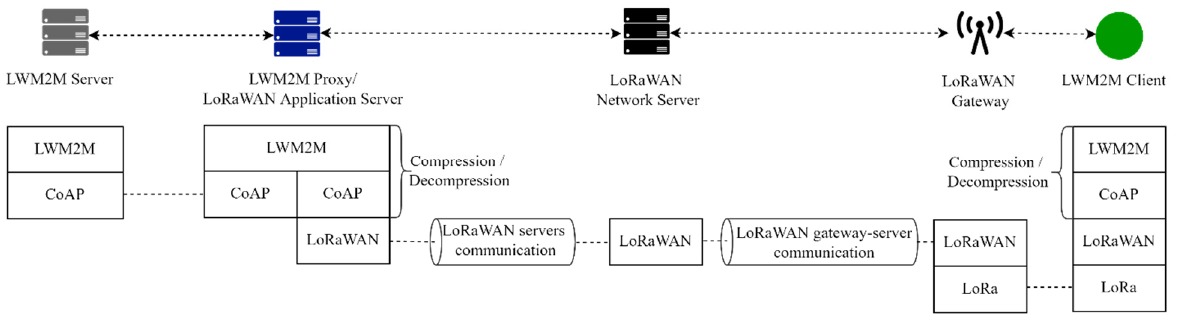
Figure 13. LWM2M architecture instantiated in a LoRaWAN network. All the servers are Java servers and the Proxy and the Server use the Eclipse Leshan library [22] to implement the LWM2M